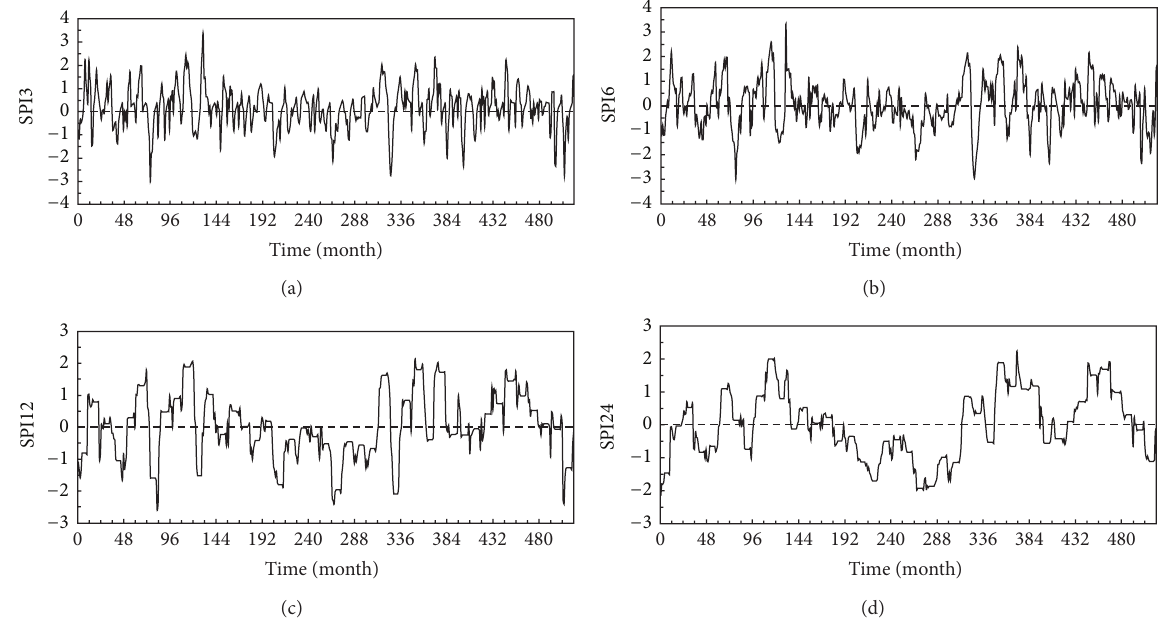
Figure 4: Standardized Precipitation Index (SPI) for the rainfall data plotted for the time scales of 3, 6, 12, and 24 months. The time duration of the data is from January 1967 (month number 1) to December 2009 (month number